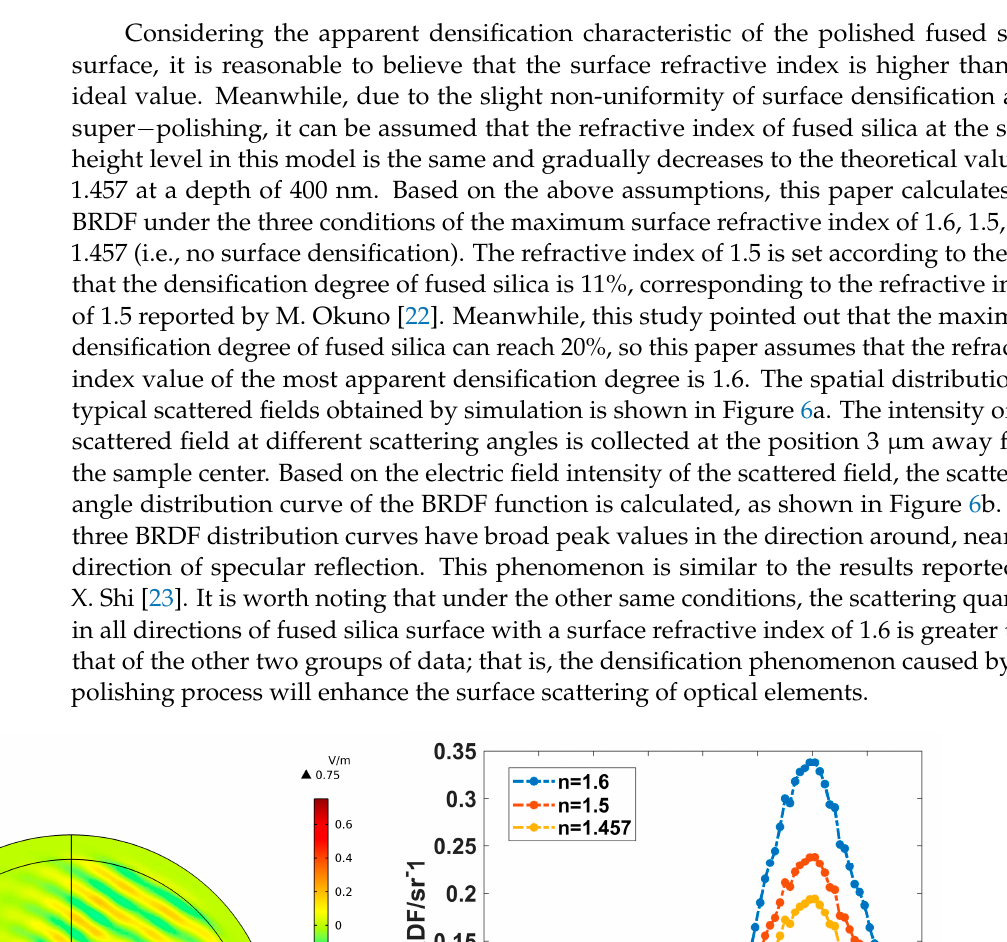
Figure 5. Schematic diagram of the surface scattering simulation model.